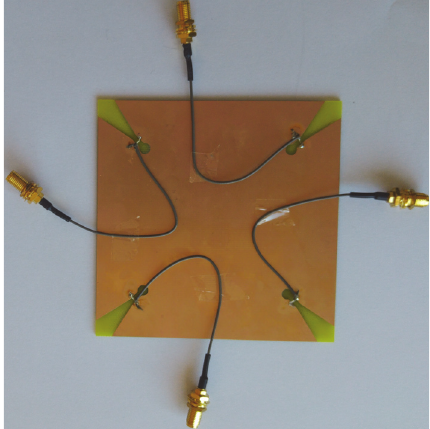
Figure 5: Prototype of Ant. 1 design.